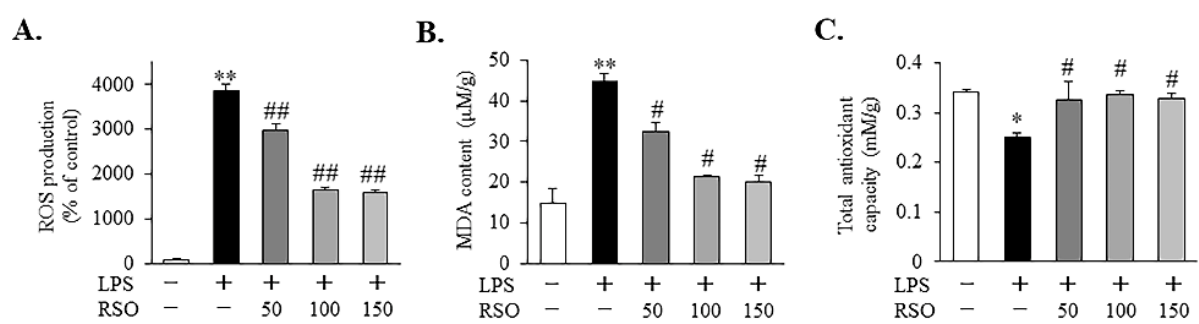
Figure 2. Effect of RSO on ROS, MDA, and T-AOC of LPS-induced RAW 264.7 cells. ( A ) ROS levels of each group, n = 6; ( B ) MDA levels of each group, n = 3; ( C ) Total antioxidant capacity (T-AOC) of each group, n = 3. * p < 0.05, ** p < 0.01 vs control group; # p < 0.05, ## p < 0.01 vs LPS-induced